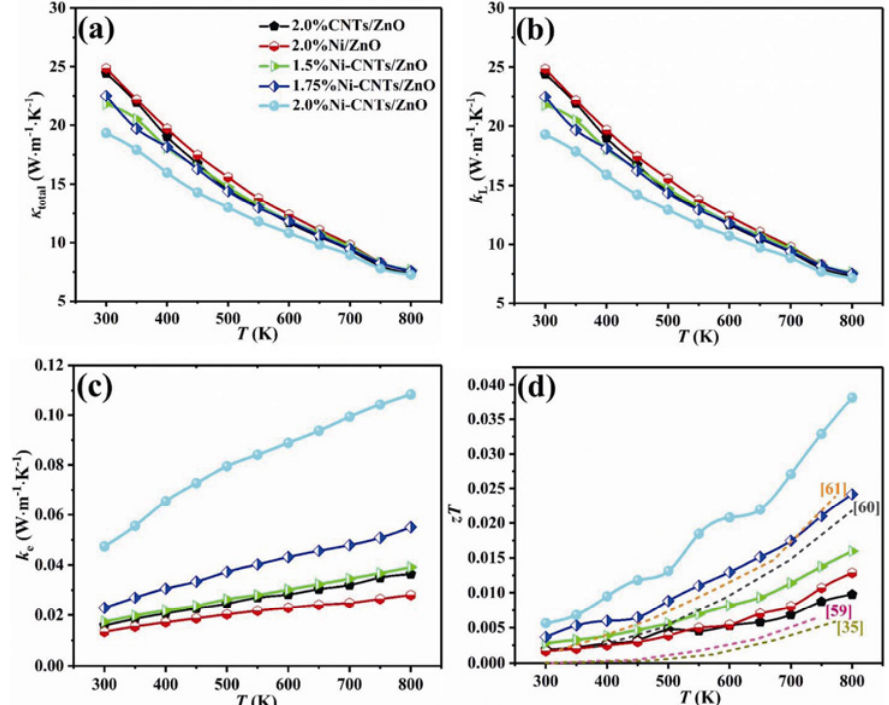
Fig. 6 Temperature dependence of (a) total thermal conductivity (